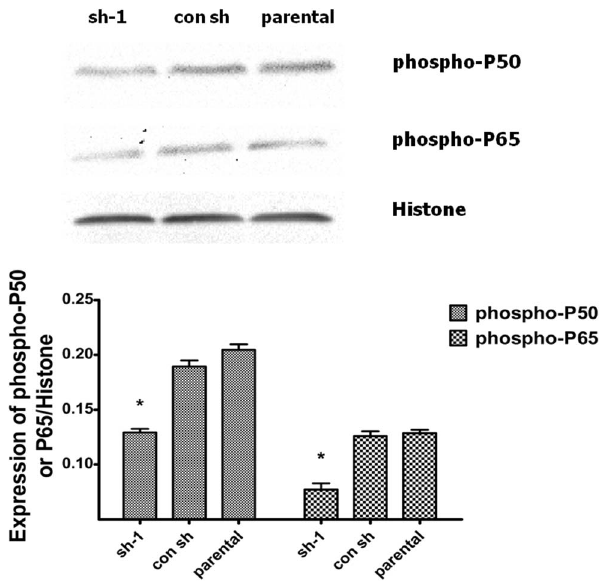
Figure 7. Effect of Prx-I-shRNA transfection on protein expression of phospho-NF- k B p50 and p65 in T24 cells by Western blots. A significant decrease in the protein expression of both phospho-NF- k B p50 and p65 in sh-1 group. (Asterisk (*)indicates P , 0.05 in sh-1 group versus parental group)